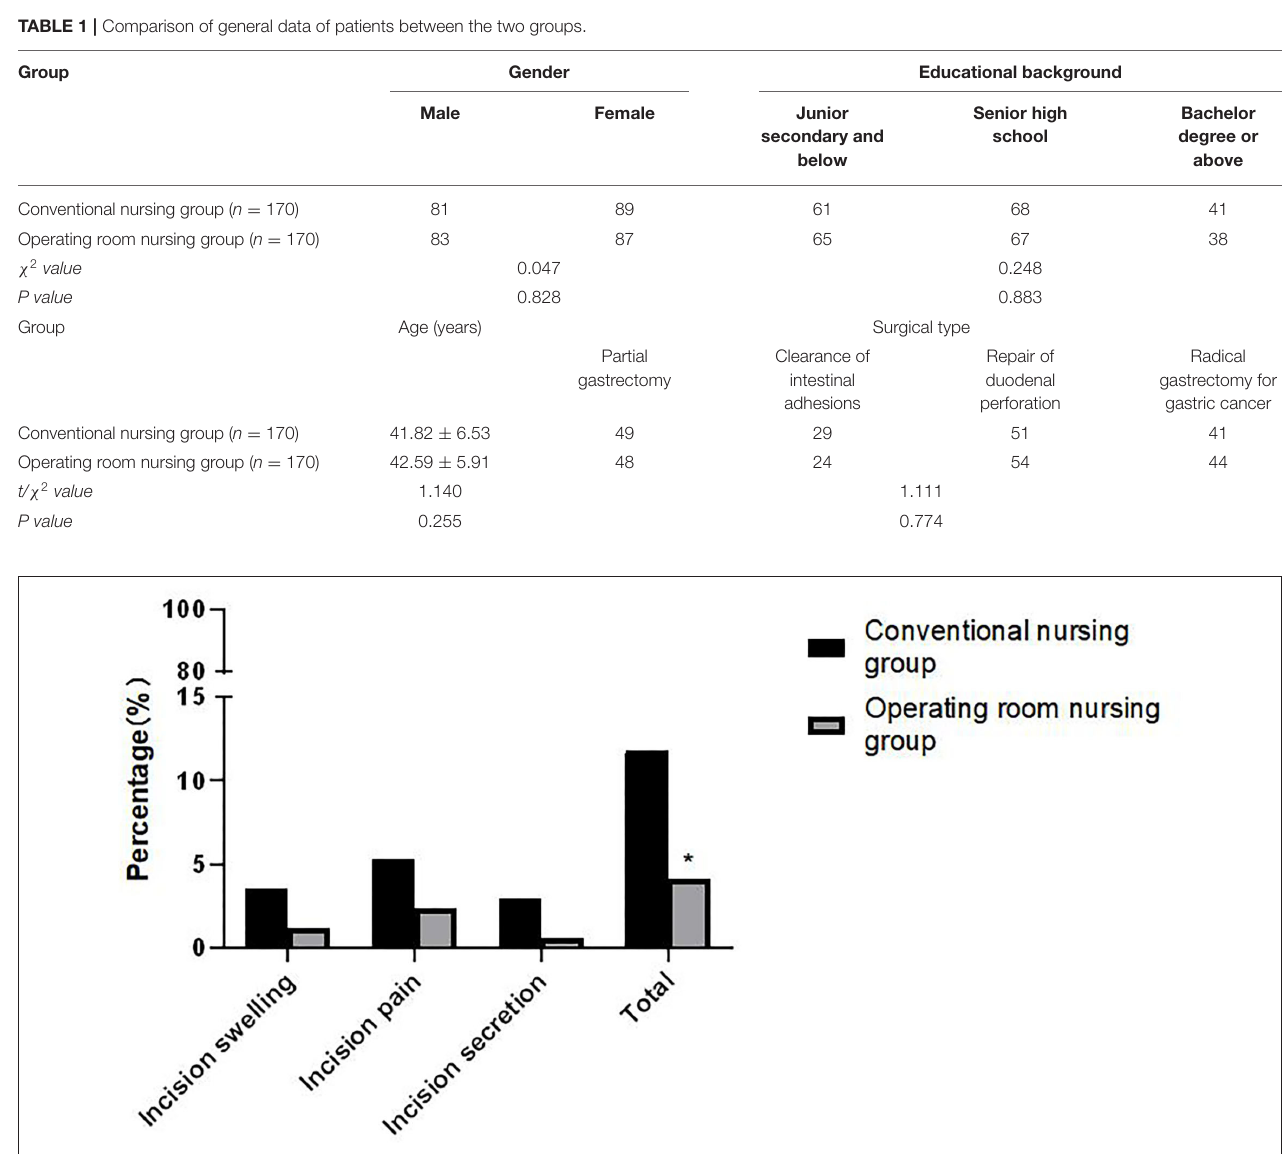
FIGURE 1 | Comparison of incision infection between the two groups. Note: Compared with the conventional nursing group, * p <